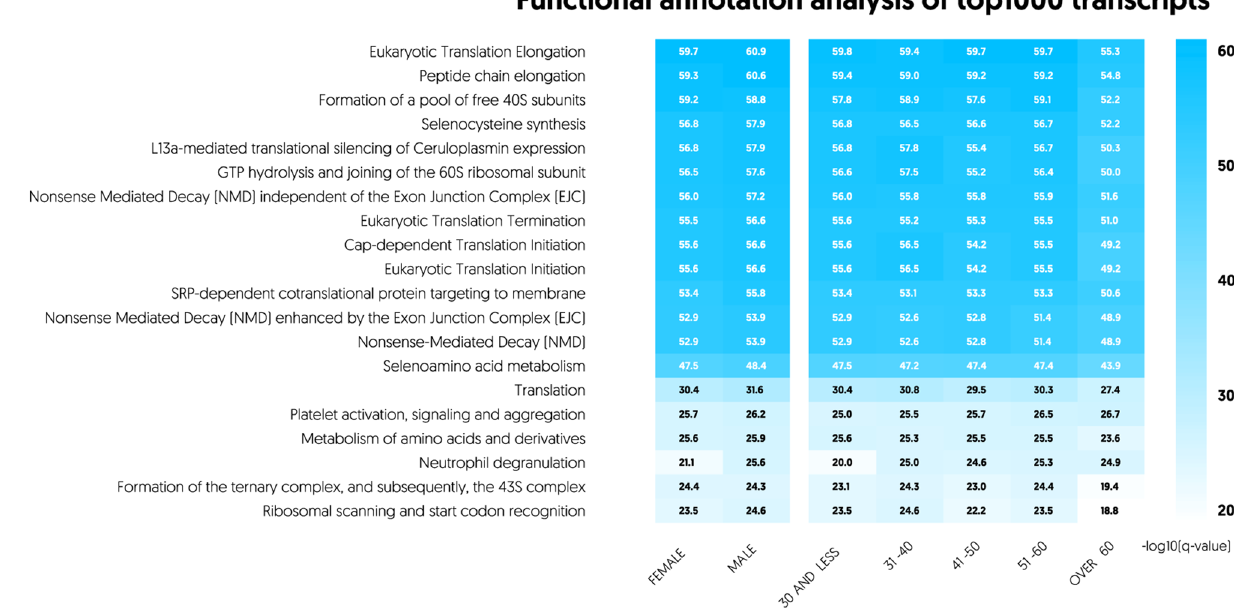
Figure 2. Functional annotation analysis of top expressed spliced genes among the analysed sex and age groups. For each group, 1000 spliced genes with the highest expression level were subjected to over- representation analysis and top20 Reactome pathways were identified based on −